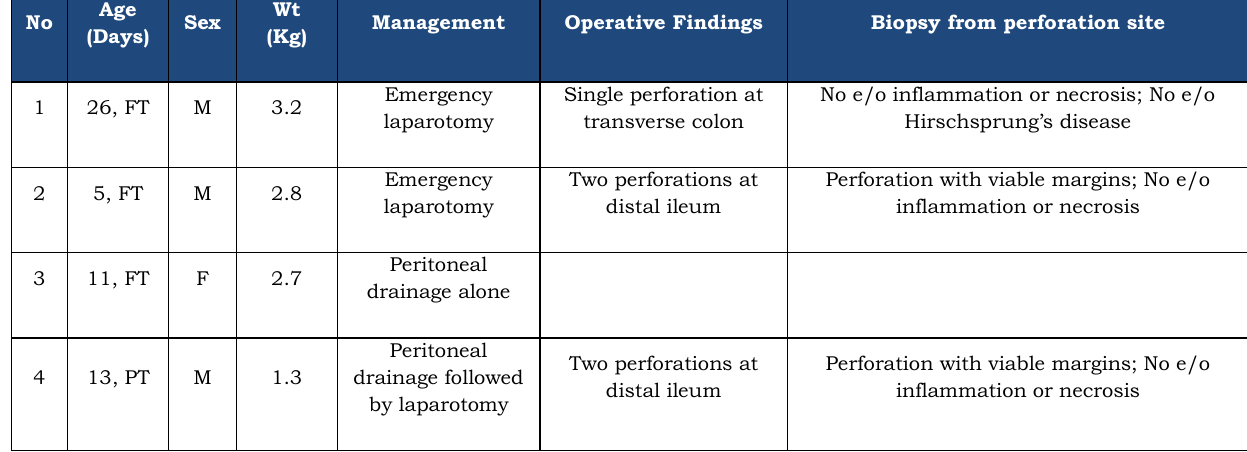
Table 1: The clinical presentation and management of the four neonates with SIP